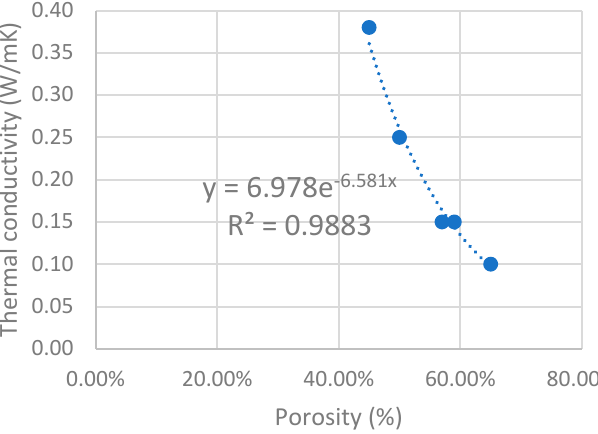
Figure 19. Thermal conductivity and porosity correlation from the study by Koksal et al. (2020) [56].